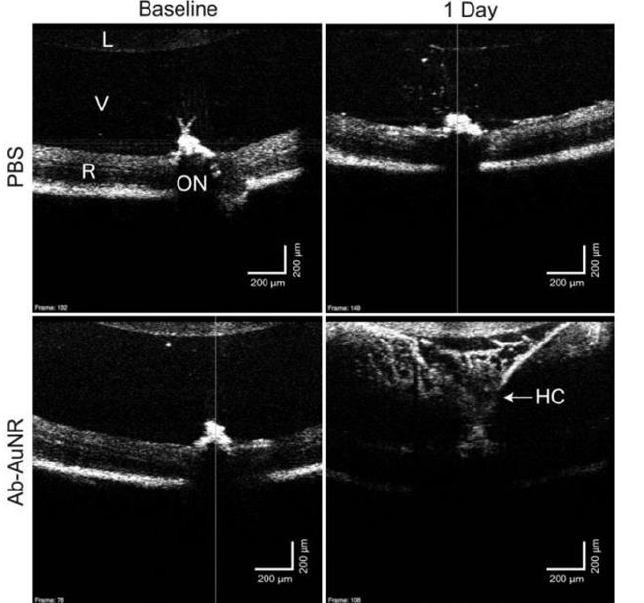
Figure 7. Baseline and one day post-injection OCT images from PBS – AuNR- and Ab – AuNR-injected mice. After the gold nanorod injection, significant signal enhancement can be seen in the vitreous in comparison to pre-injection and the sham injection images. The shadow occurring from the strong vitreous signal reduces the signal from the retina. The hyaloid canal (HC), the lens (L), the optic nerve (ON), the retina (R) and the vitreous (V) are visible in the above images [92]. The formation of opacities in OCT images and this “shadowing effect” was also ob- served by Gordon et al. [93] who performed intravitreal injections of bare Au nanorods (CTAB-coated) in mice. Within a few minutes of injection, an amorphous opacity became apparent and retinal visualization was obscured. The surface CTAB was then displaced with PEG; in this case, the injection did not cause these morphological changes. Even though PEG-coated GNRs seemed to be viable agents for in vivo imaging experiments, they were not able to reach the retina through the vitreous due to their size.